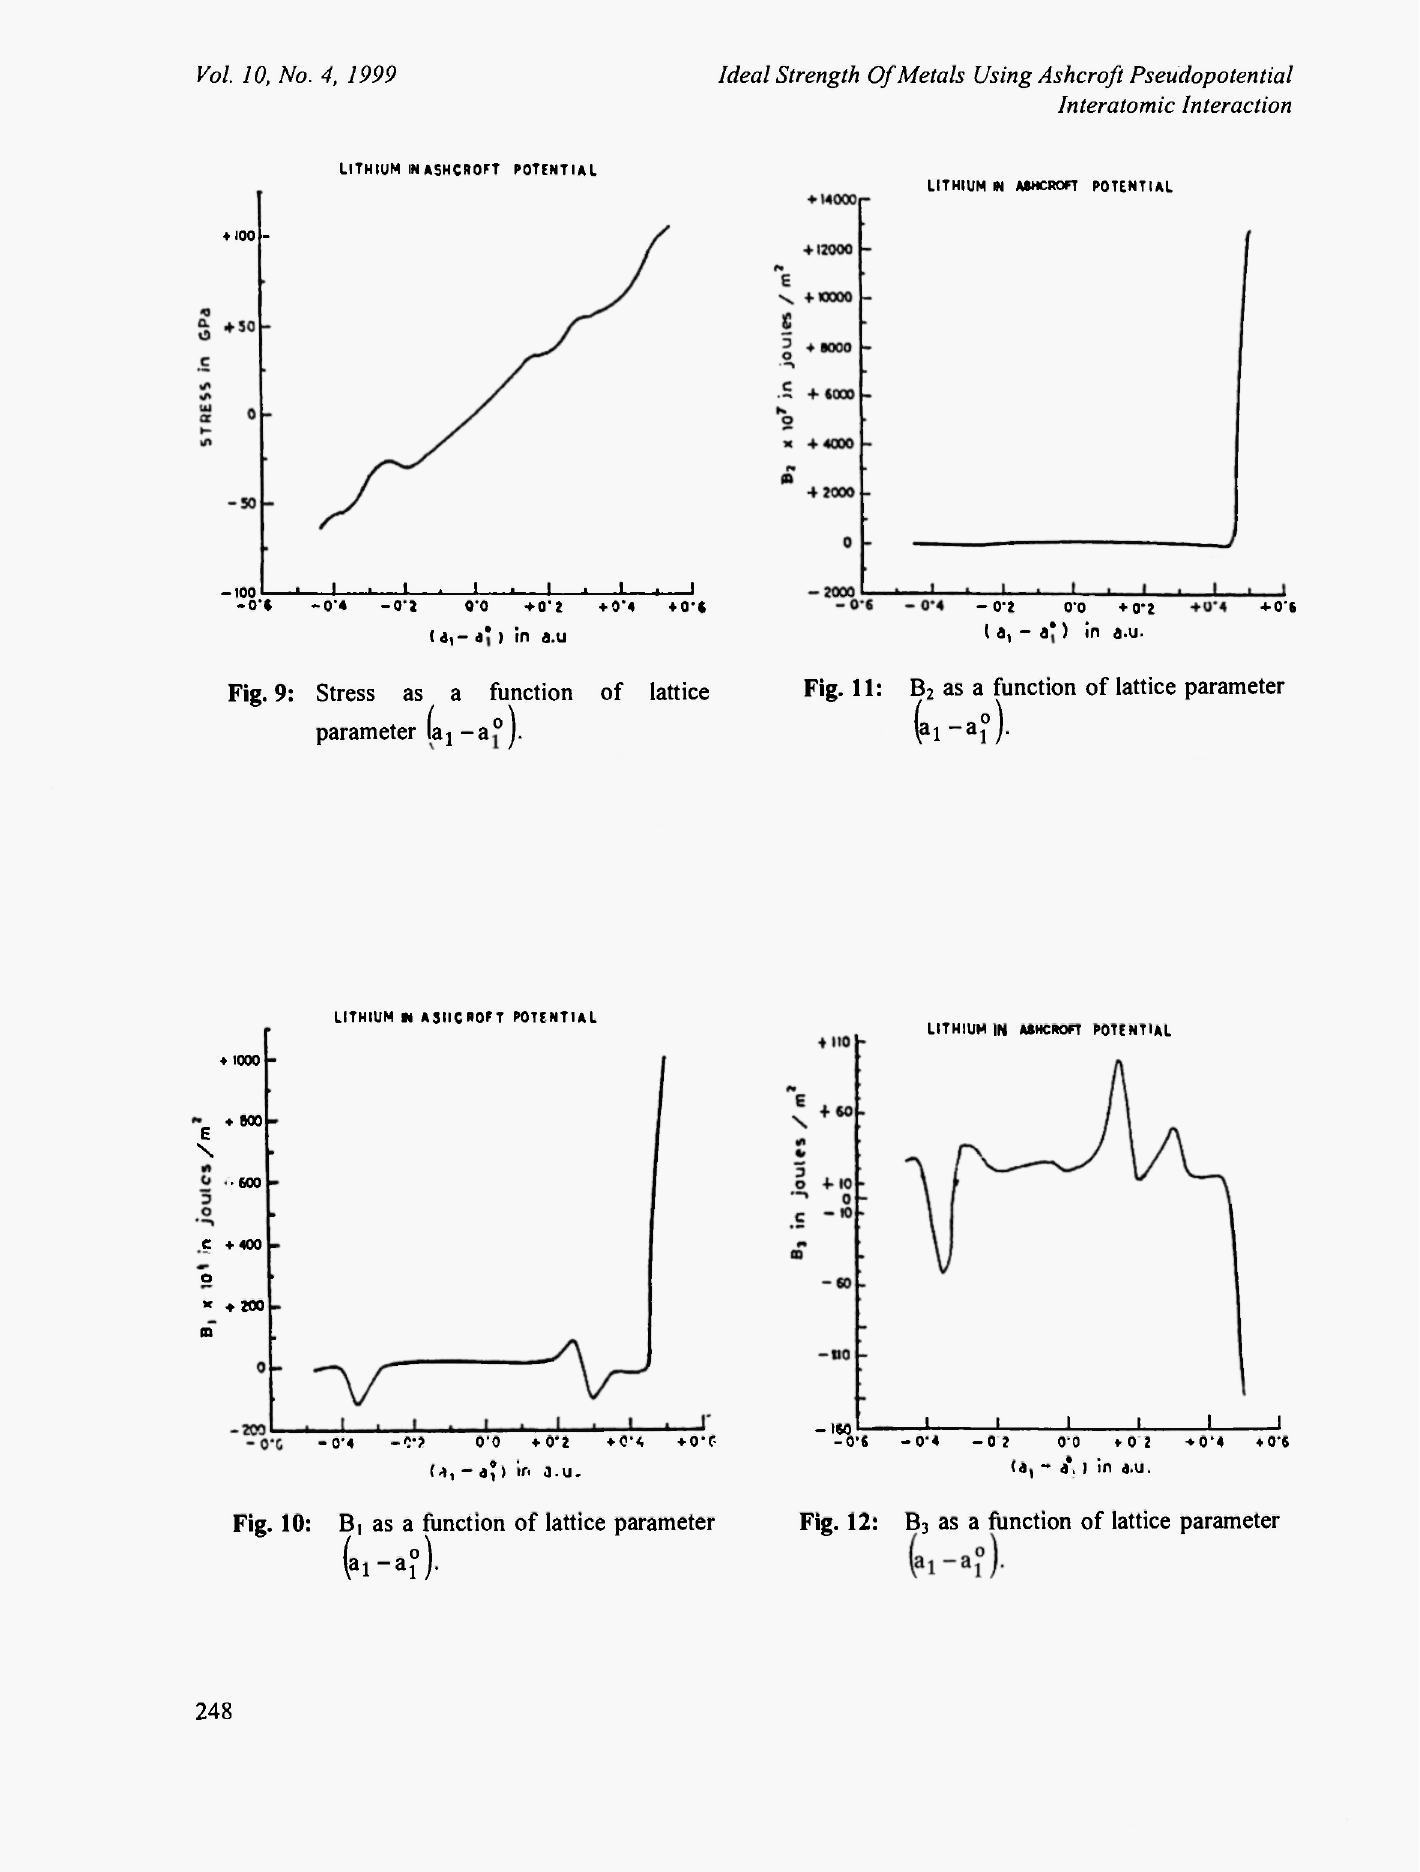
Fig. 10: Bi as a function of lattice parameter Fig. 12: B 3 as a function of lattice parameter